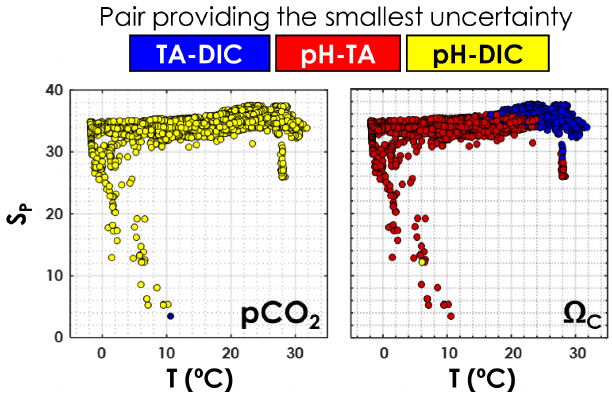
Figure 6. Pair of carbonate system variables (TA–DIC, TA–pH, or DIC–pH) providing the lowest overall relative uncertainty, as a function of in situ temperature and practical salinity, for p CO 2 and (cid:127) Ca . This is computed using all data points from GLODAPv2 that contain T , P , S P , DIC, TA, pH, [SRP], and [DSi] in the top 10m of the water column (3392